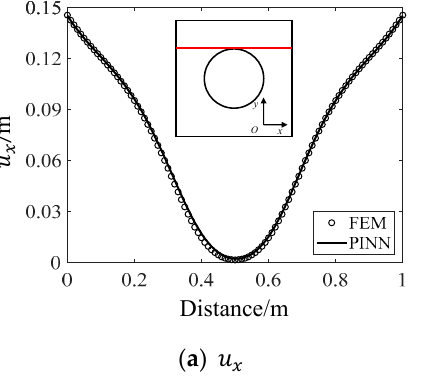
( b ) 𝑢 (cid:3052) Figure 8. Comparison of the obtained displacement, represented by the red line (from left/bottom to right/top). ( a ) horizonal and ( b ) vertical displacement distributions of the marked regions.